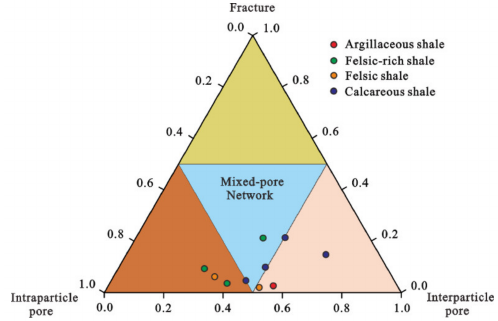
Figure 18. Pore type distributions of the four lithofacies